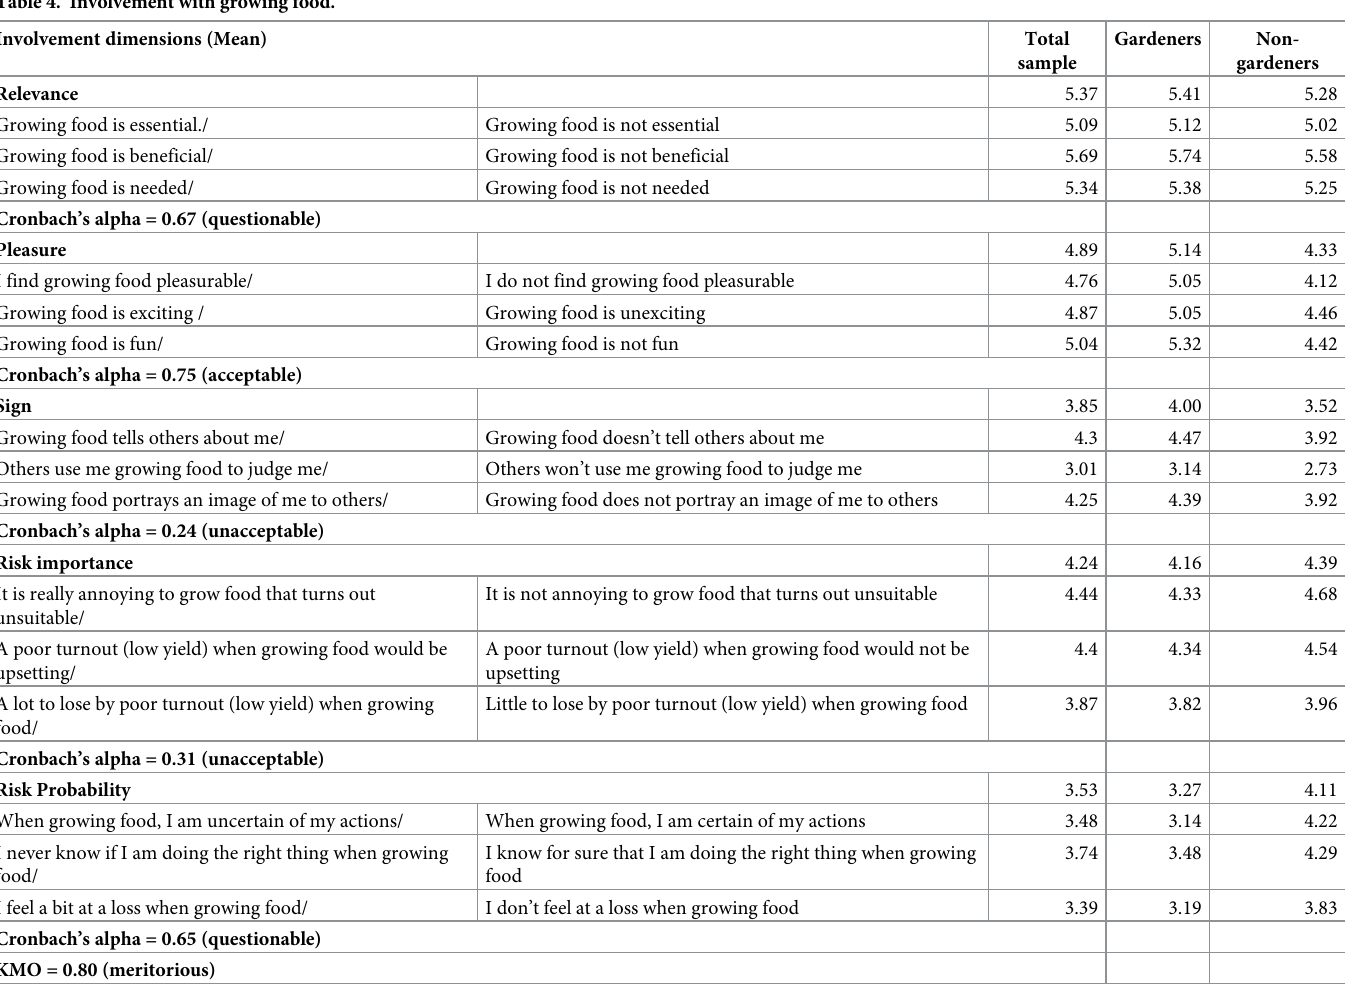
Table 4. Involvement with growing